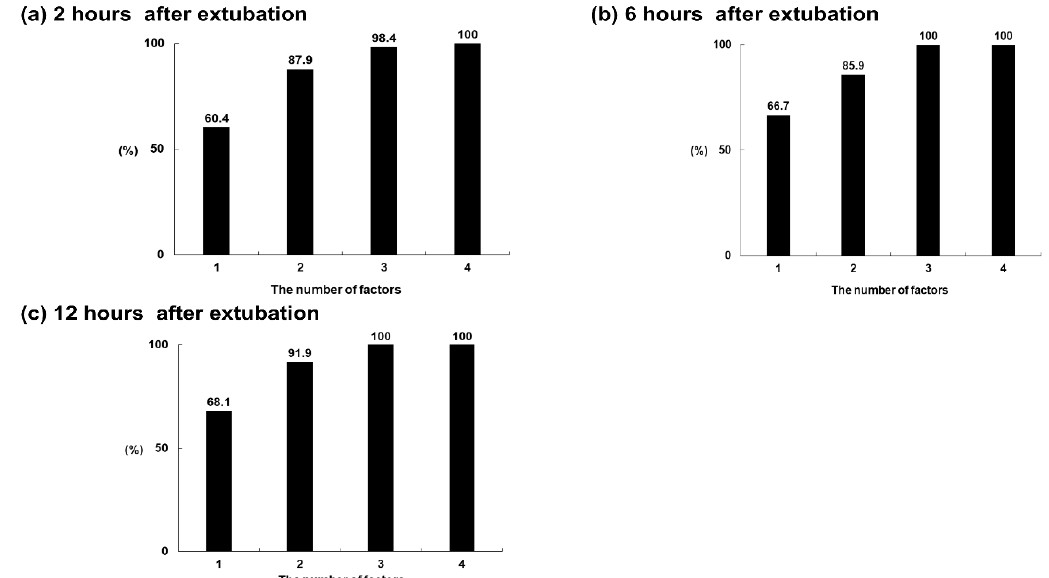
Figure 3. The changes in predictive value for HFNC success within 72 h according to the number of factors associated with HFNC success at each time point. ( a ) Changes in predicted values according to changes in factors, such as an ROX index at 2 h of >8.7, female sex, BMI >21.53 kg/m 2 , and a total duration of ventilator management of ≤ 8 days. ( b ) Changes in predicted values according to changes in factors, such as an ROX index at 6 h of >8.7, female sex, BMI >21.53 kg/m 2 , and a total duration of ventilator management of ≤ 8 days. ( c ) Changes in predicted values according to changes in factors, such as an ROX index at 12 h of >8.7, female sex, BMI > 21.53 kg/m 2 , and a total duration of ventilator management of ≤ 8 days. Sequential increases in factors associated with the success of HFNC (e.g., ROX index at 2 h, 6 h, and 12 h, female sex, BMI > 21.53 kg/m 2 , and a total duration of ventilator care ≤ 8 days) improved the predictive capability for HFNC success within 72 h.